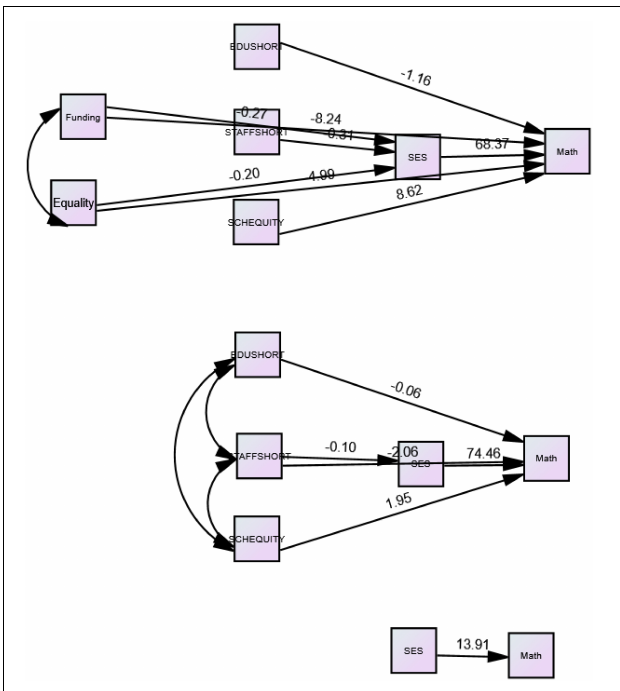
FIGURE 3 | Partial mediation model for math with parameter estimates.